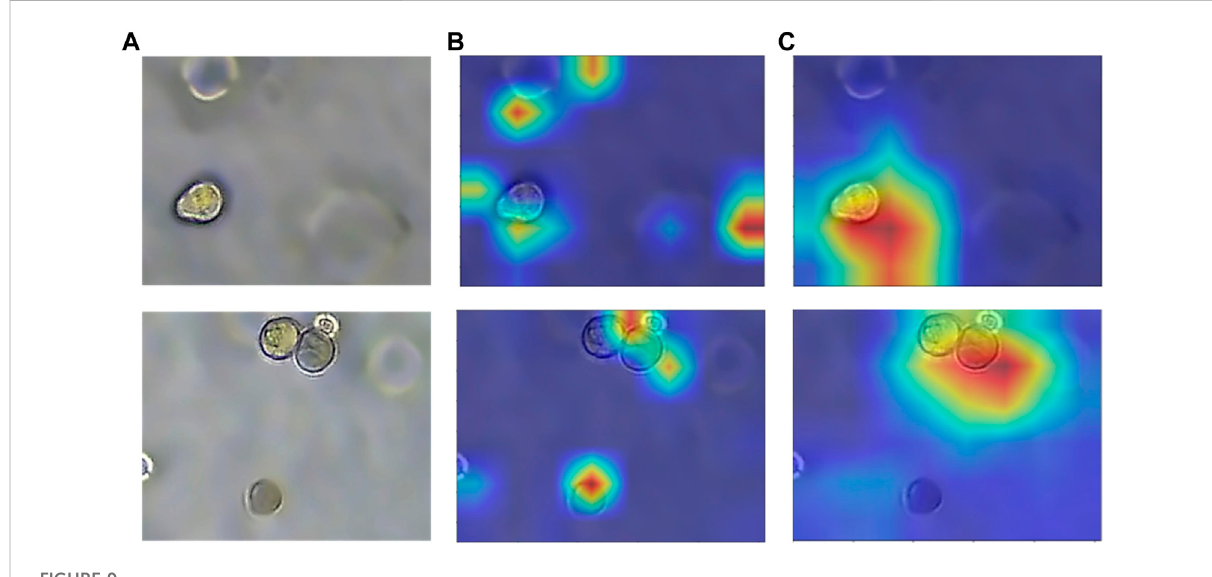
FIGURE 9 Heatmap with or without attention module. (A) Original image of organoids. (B) Heatmap without attention. (C) Heatmap with attention. The model with added attention is able to better focus on the target region.